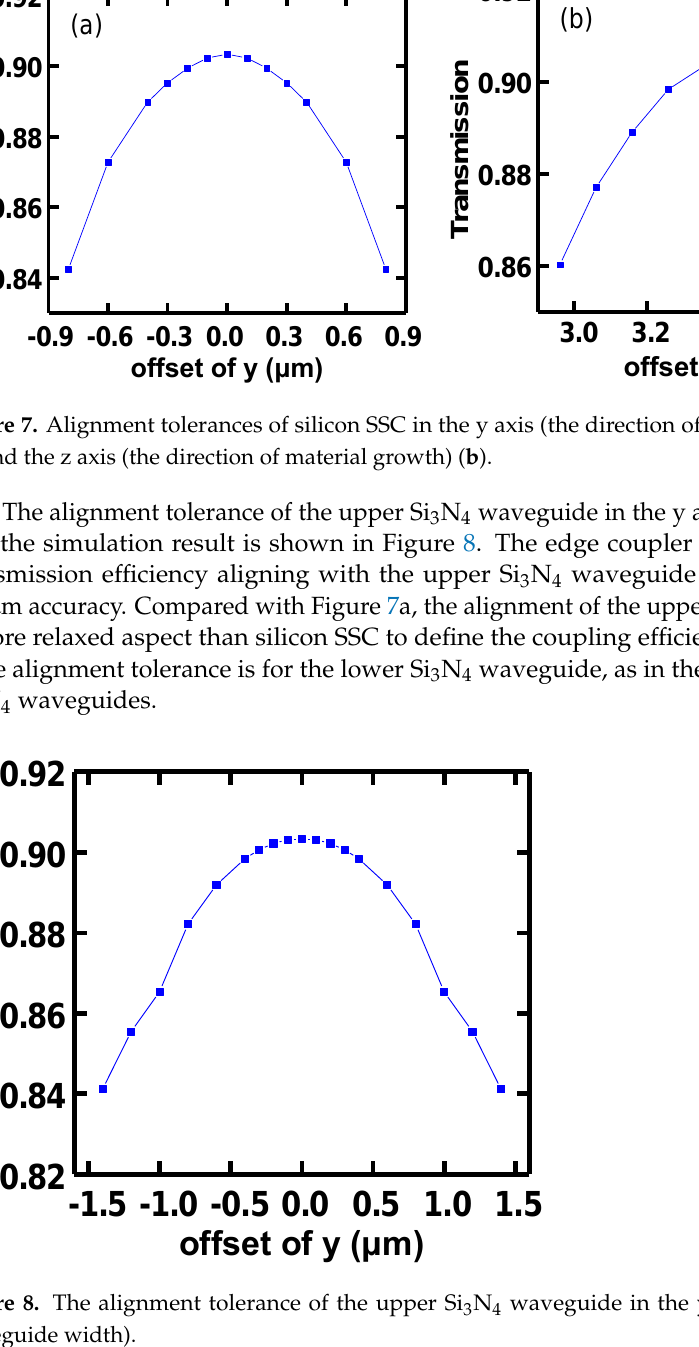
Figure 8. The alignment tolerance of the upper Si 3 N 4 waveguide in the y axis (the direction of waveguide width).